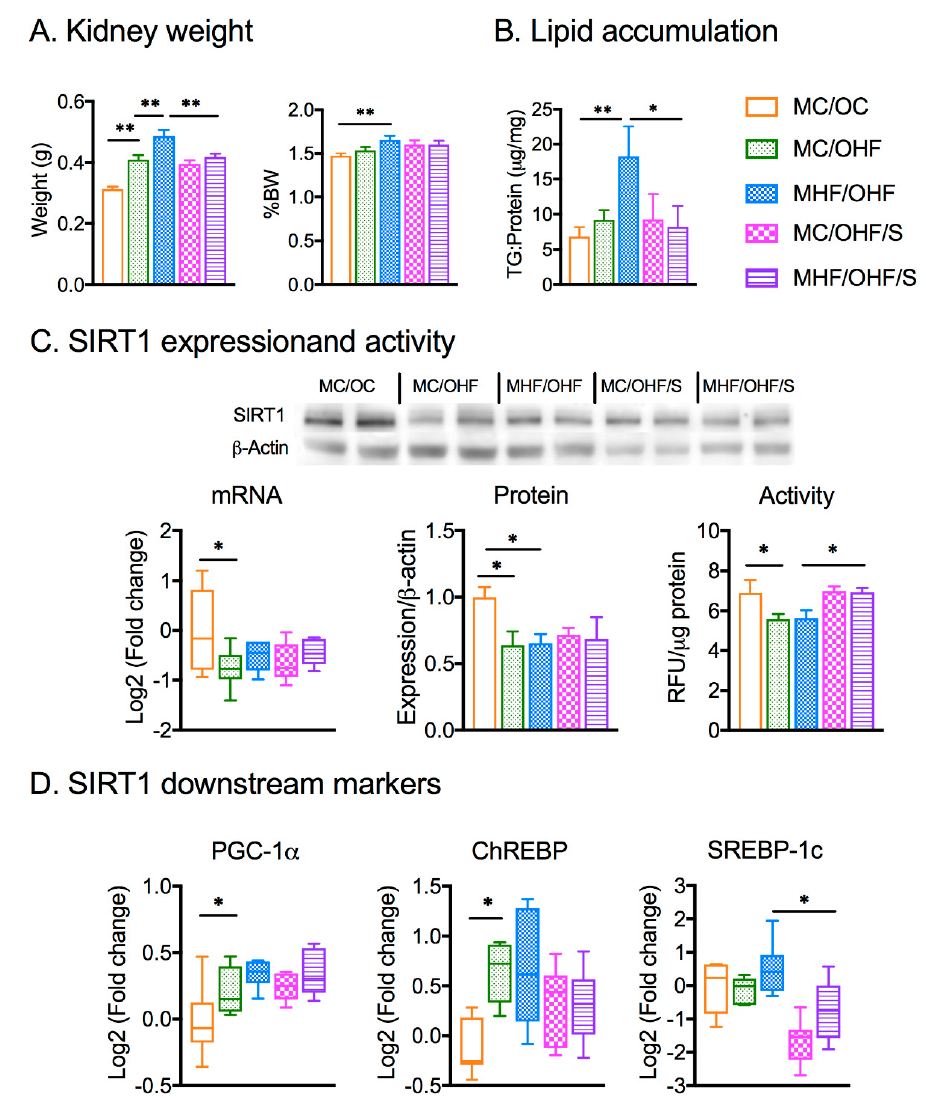
Figure 5. SRT1720 suppresses renal lipid accumulation in offspring due to maternal and postnatal HFD consumption. ( A ). Kidney weight ( n = 9–17). ( B ) Kidney triglyceride level ( n = 8). ( C ) SIRT1 expression and activity. ( D ) mRNA expression of SIRT1 downstream markers ( n = 8). Data are expressed by mean ± SEM or box plot (min to max, the central lines indicate the median). SIRT: sirtuin; PGC-1 α : peroxisome proliferator-activated receptor gamma coactivator 1 alpha; SREBP-1c: sterol